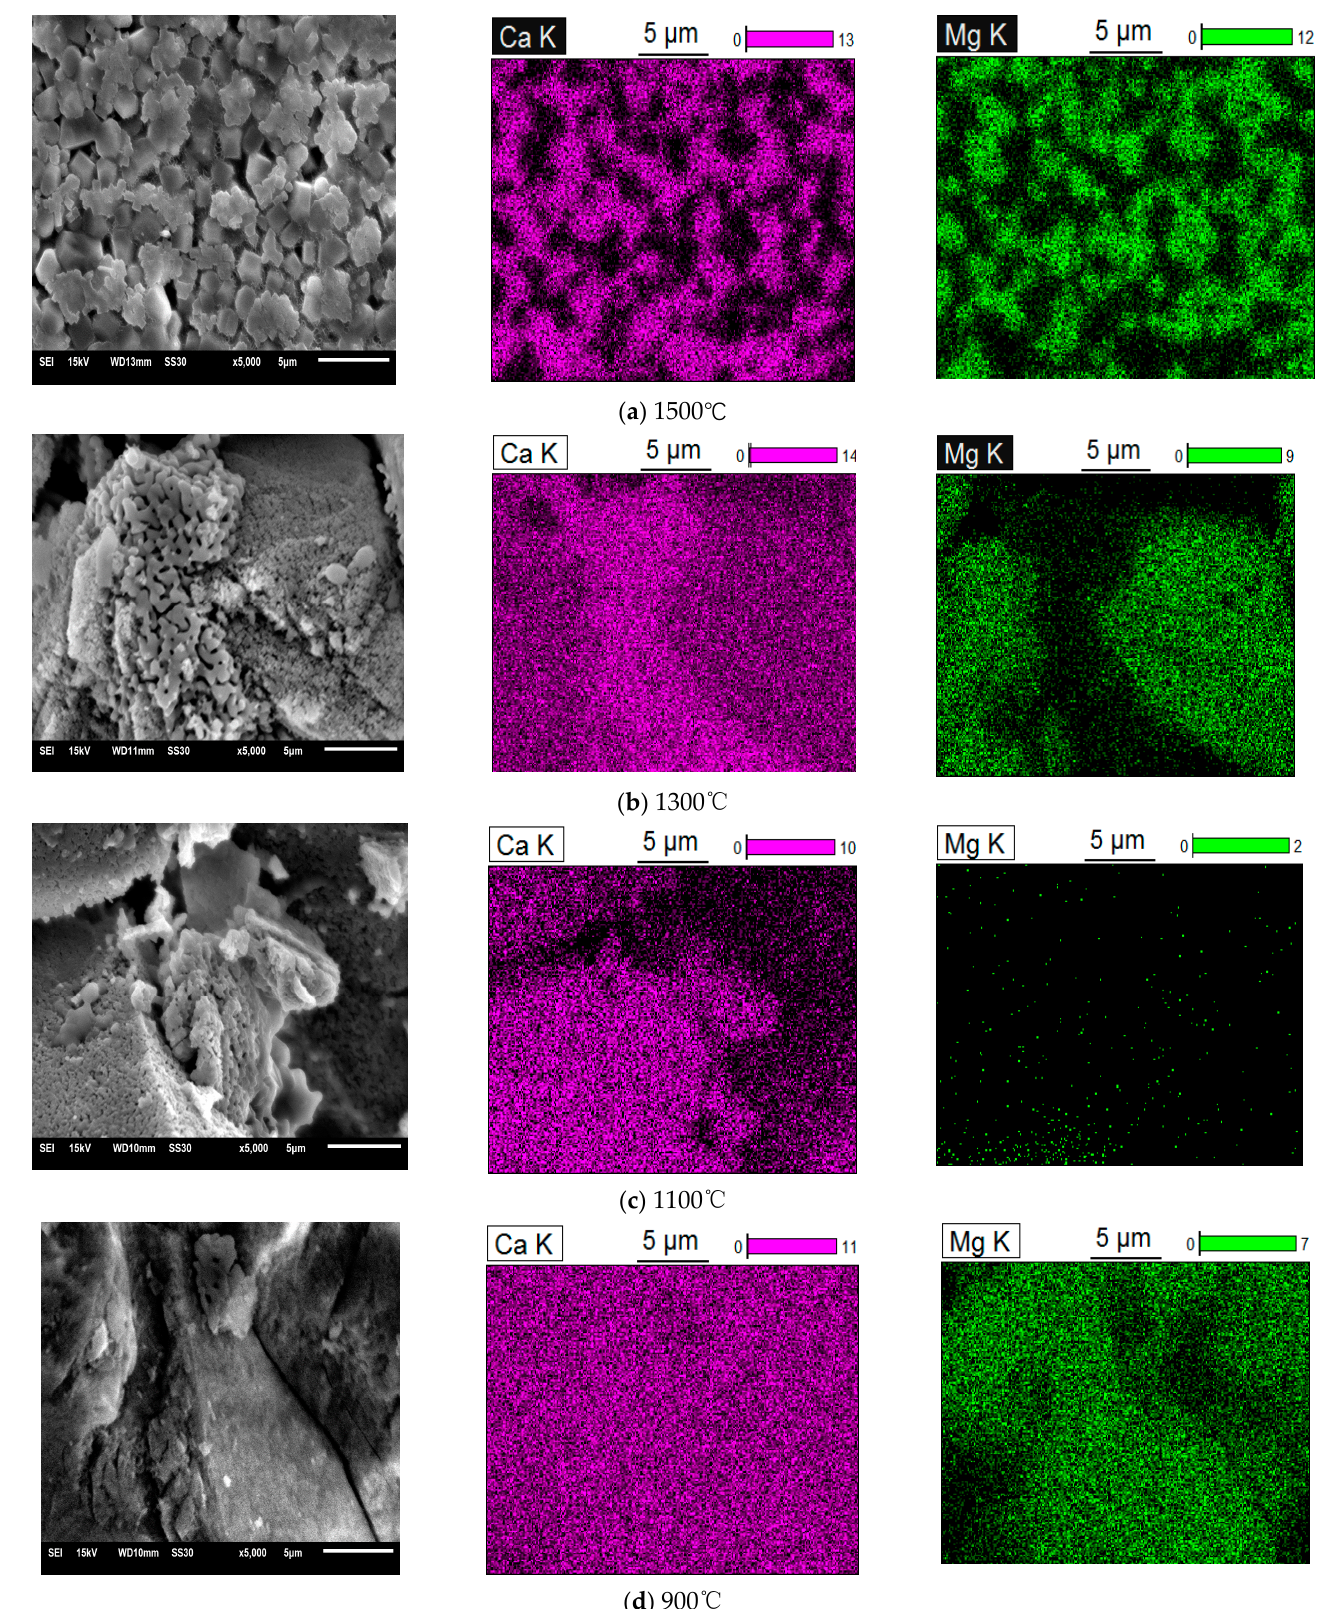
Figure 2. SEM images of dolomite products held at different calcination temperatures for 1 h.